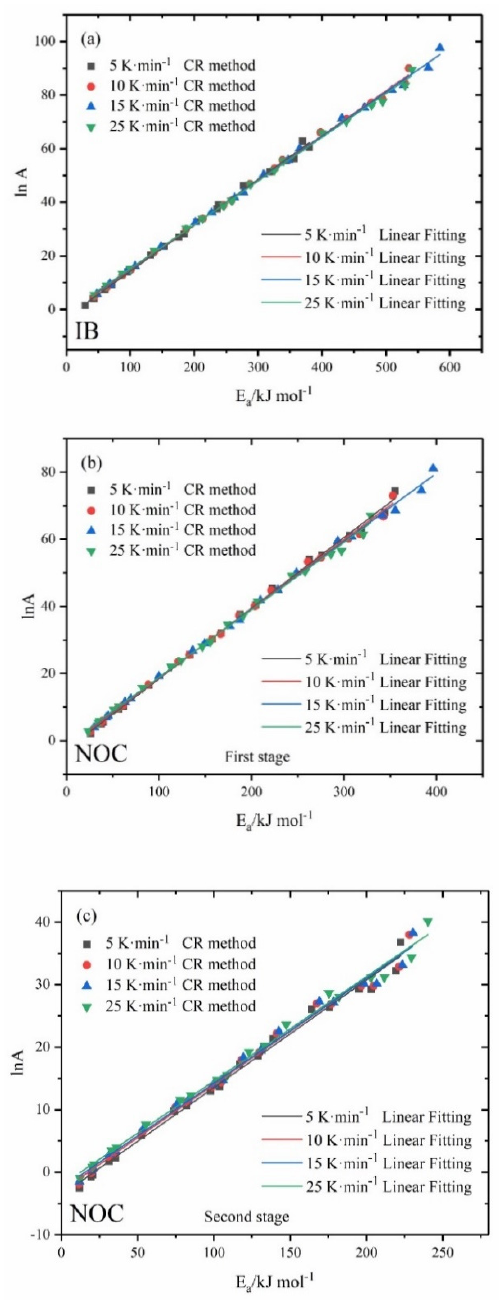
Figure 4. The Kinetic Compensation Effect relationships by CR method at different heating rates: ( a ) IB, ( b ) the first pyrolysis stage of NOC, ( c ) the second pyrolysis stage of NOC.